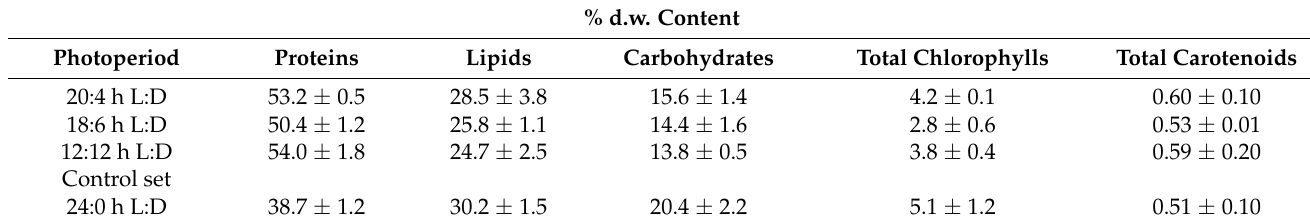
Table 12. Effect of photoperiod on biomass biochemical composition. % d.w.